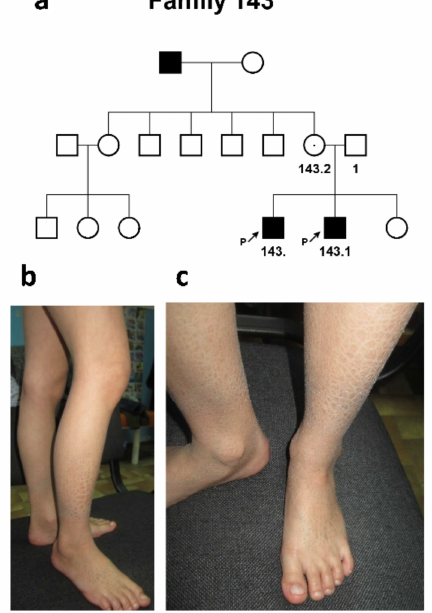
Figure 3. Family #143. ( a ) Three-generation pedigree #143 with 3 patients, 2 siblings (#143 and #143.1), and maternal father (who was not available for clinical examination and molecular diagnosis); ( b , c ) patient #143. Brown skin scales of various sizes, from small (2–3 mm) to larger (12–17 mm) on the